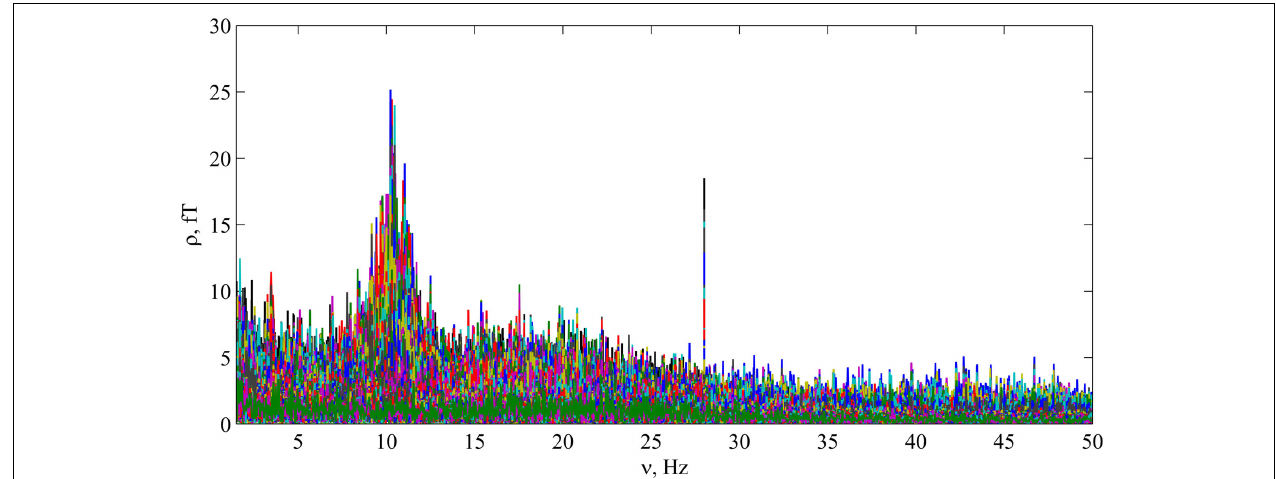
FIGURE 1 | Precise multichannel Fourier spectrum for the auditory recording JG03_01. Multiple peaks corresponding to alpha activity can be seen near 10Hz. Also the second harmonic of the stimulus frequency is well noticeable at 28Hz.